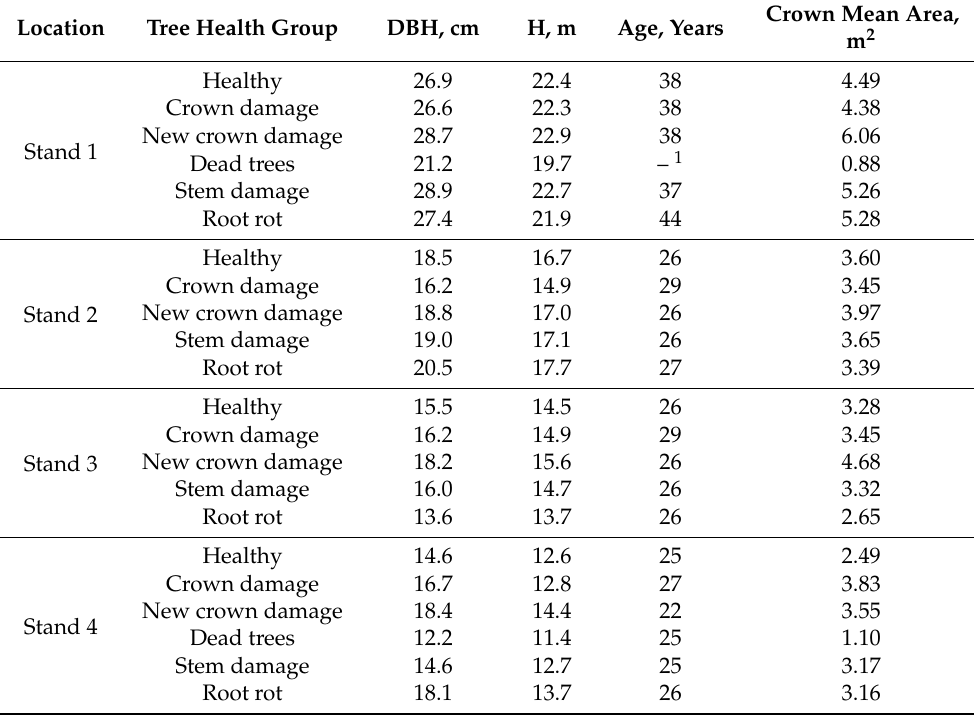
Table 5. Descriptive statistics of